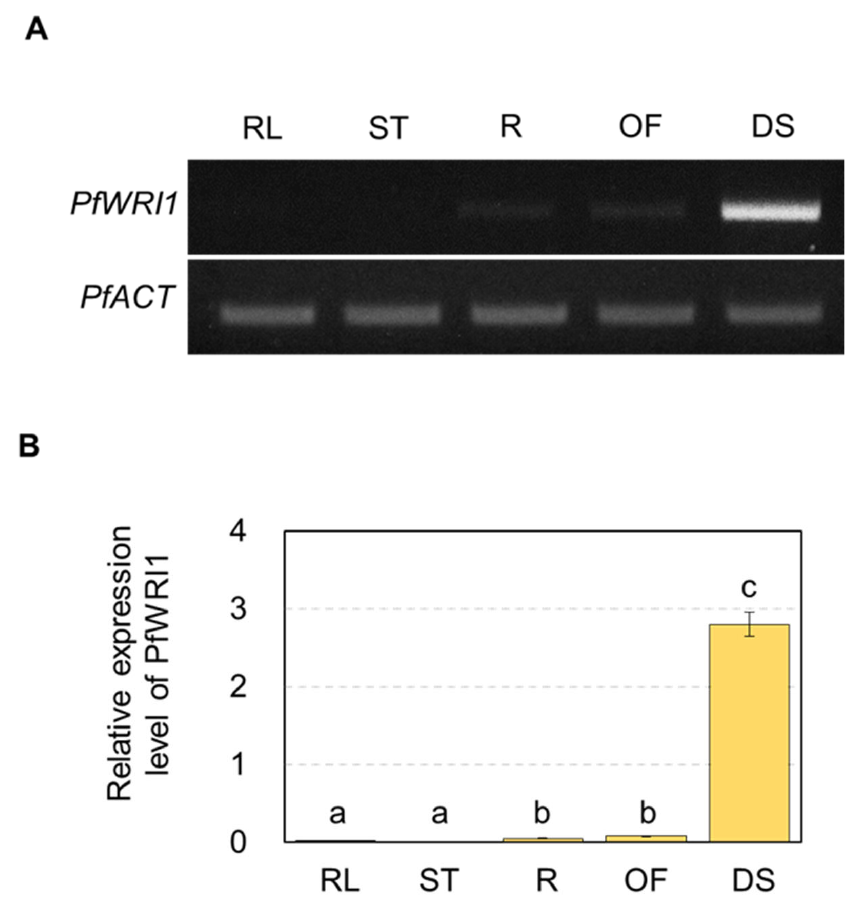
Figure 2. Expression of Perilla WRI1s in various P. frutescens organs. ( A ) RT-PCR analysis of PfWRI1s in various P. frutescens organs. Total RNAs were isolated from rosette leaves (RL), stems (ST), roots (R), and open flowers (OF) of 3-month-old Perilla plants and developing seeds (DS) for 2 to 3 weeks after flowering. P. frutescens ACTIN ( PfACT ) was used to determine cDNA quantity and quality. ( B ) RT-qPCR analysis of PfWRIs1 in various P. frutescens organs. The PfACT was used to normalize the levels of PfWRI1 transcripts. Values are the means of the ± SE of three replicates. Data were statistically analyzed using ANOVA test ( p <